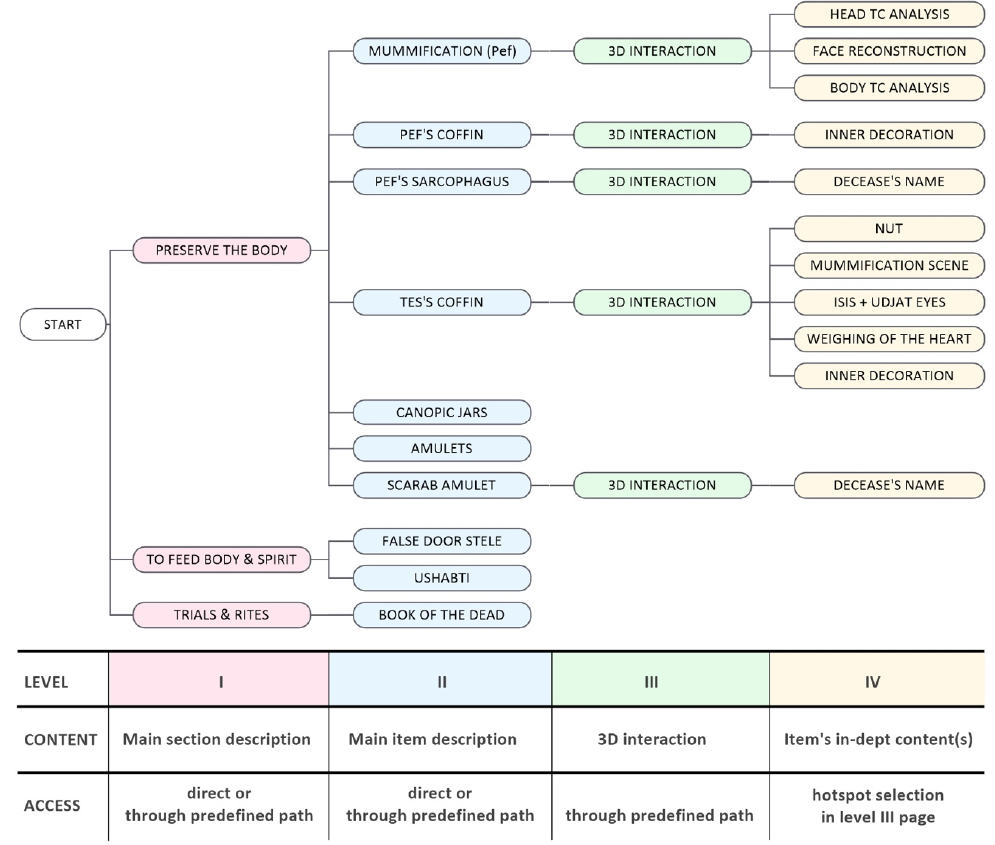
Figure 5. Diagram of the interactive digital application